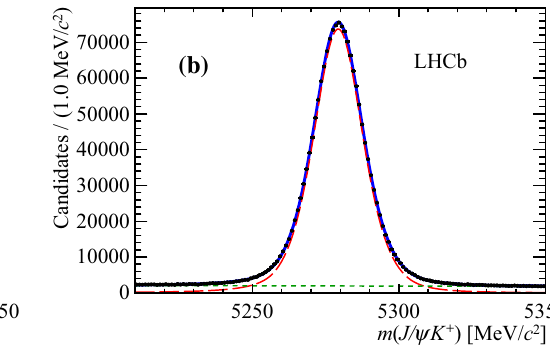
Fig. 4 Distribution of the invariant mass of selected a B 0 → J /ψ K + π − and b B + → J /ψ K + decays used for the calibration and validation of the decay-time efficiency. The signal component is shown